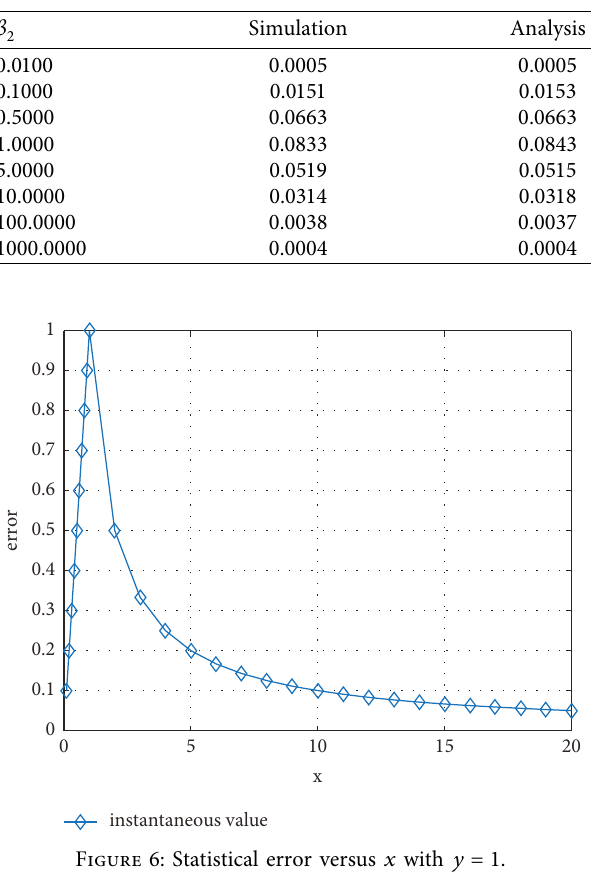
Table 5: Data of statistical error versus β